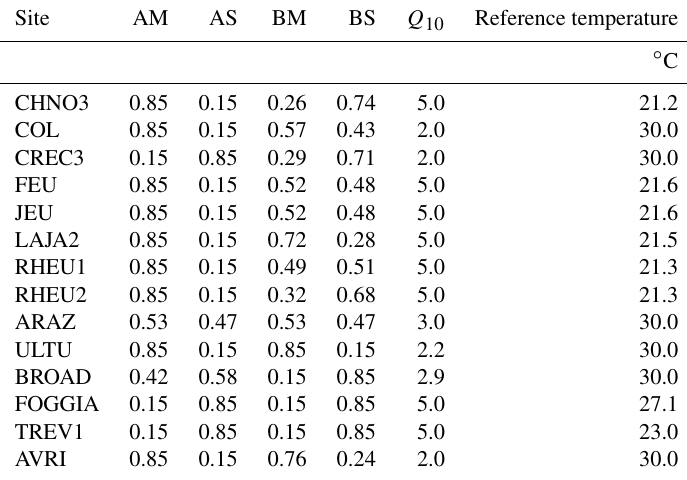
Table 3. Optimized values of the aboveground metabolic (AM), aboveground structural (AS), belowground metabolic (BM) and belowground structural (BS) fractions of the litter inputs and the Q10 and reference temperature ( ◦ C) parameters. Site AM AS BM BS Q 10 Reference temperature ◦